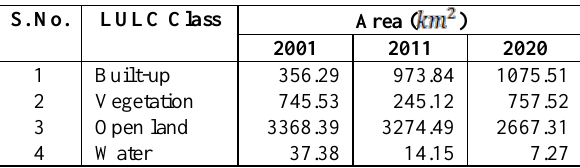
Table 4. Area of each class in the classified images of